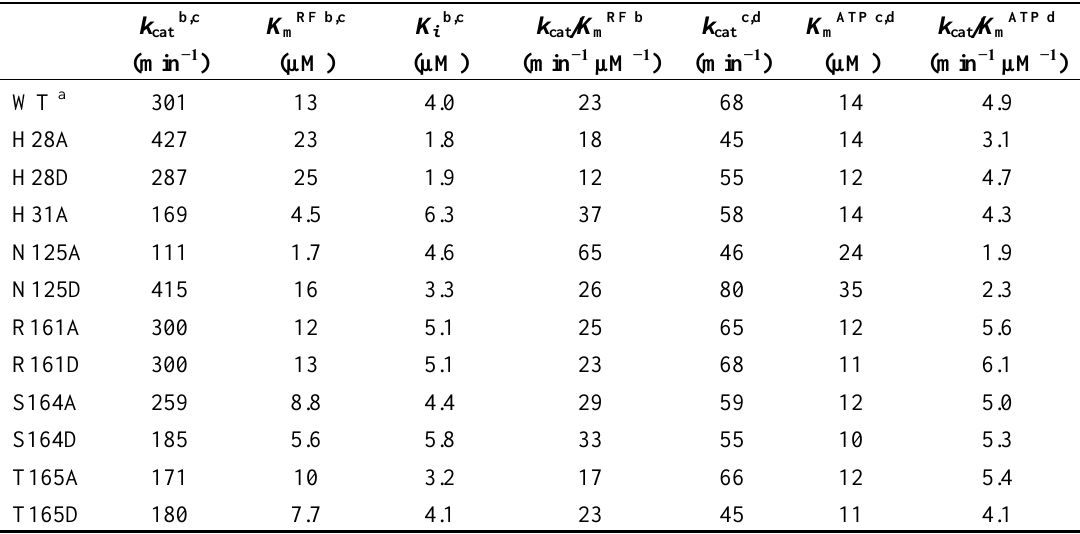
Table S2. Steady-state kinetic parameters for the RFK activity (RF + ATP → FMN + ADP) of the different Ca FADS forms. Data obtained at 37 °C in 20 mM PIPES, 0.8 mM MgCl , pH 2